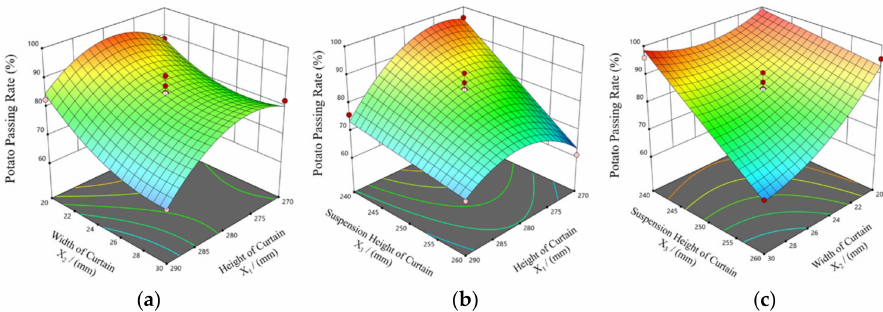
Figure 7. Response surface of interaction factors to coefficient of force on the potato Y 1 . ( a ) Response surface under factors X 1 and X 2 . ( b ) Response surface under factors X 1 and X 3 . ( c ) Response surface under factors X 2 and X 3 .